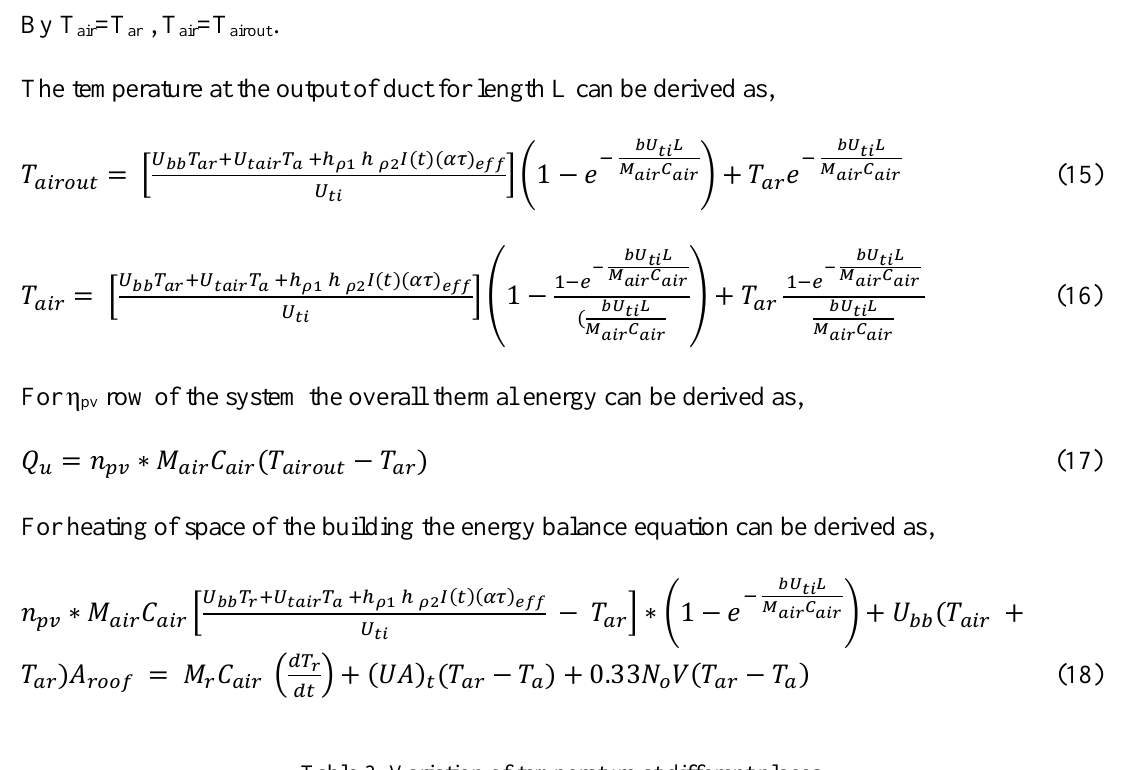
Table 3. Variation of temperature at different places